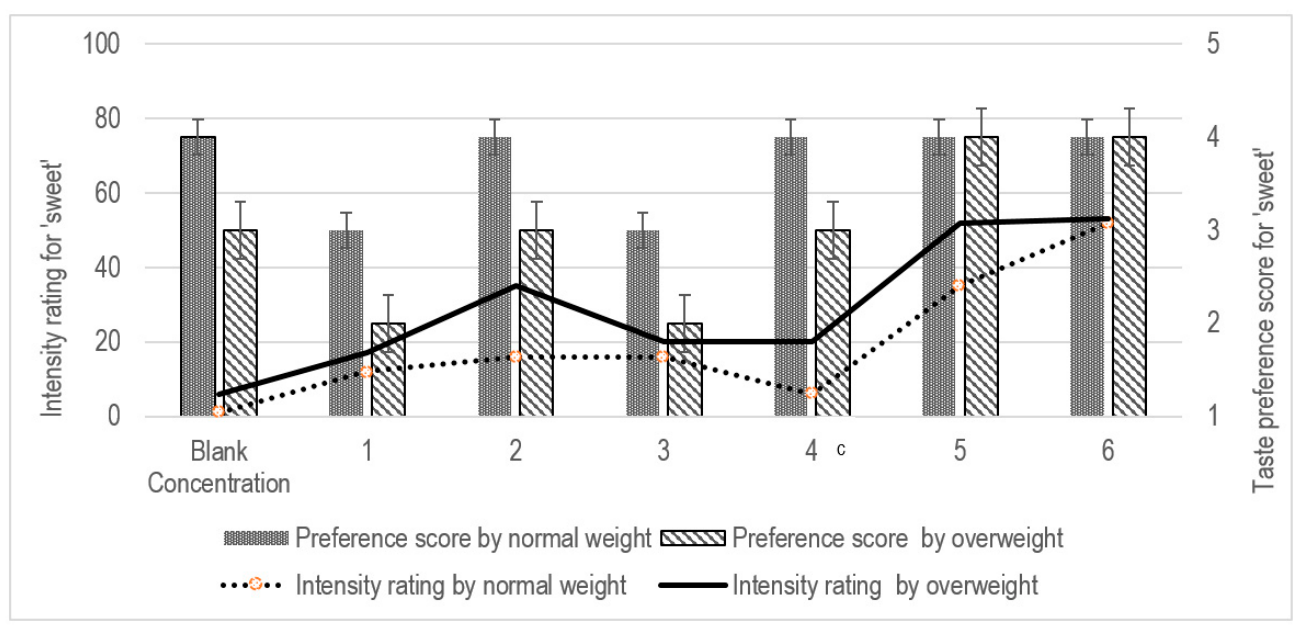
Figure 3. Intensity rating and taste preference for ‘bitter’ between the study groups .